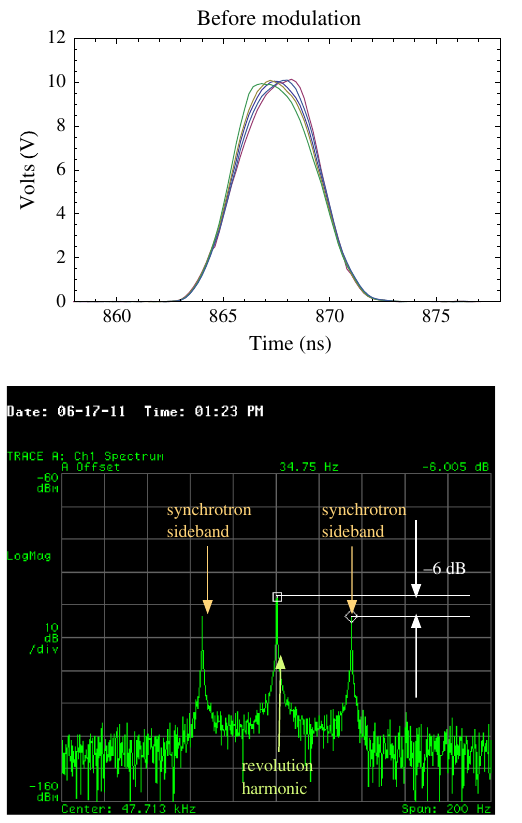
FIG. 11. These figures show how the bunch shape evolves after the first, third, fifth, and seventh modulation. After the seventh modulation, the synchrotron amplitude is reduced by about 14 dB with respect to its size before any